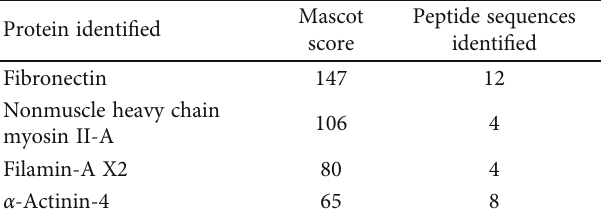
Table 2: Proteins interacting with glucaric acid as identi fi ed by